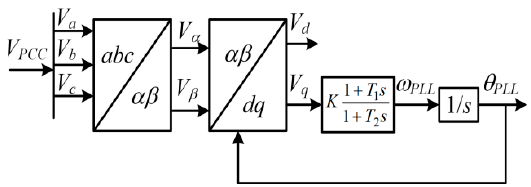
Figure 3. Schematic diagram of Lead/Lag PLL.